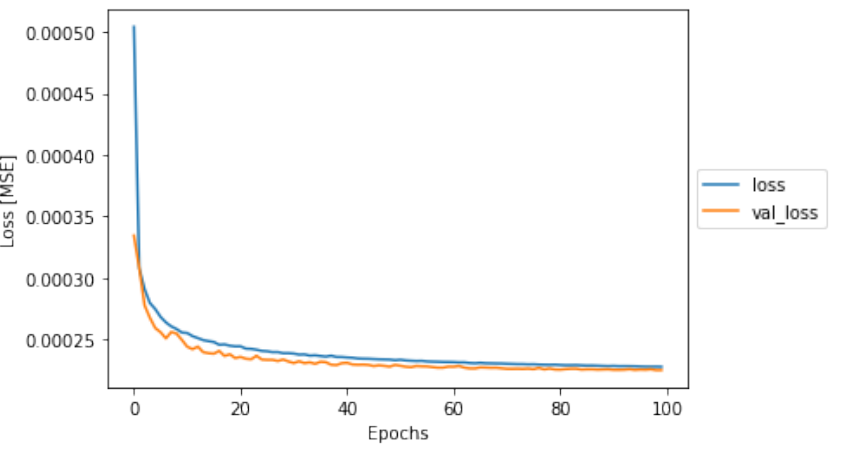
Figure 5. Training (in blue) and validation (in orange) MSE loss over